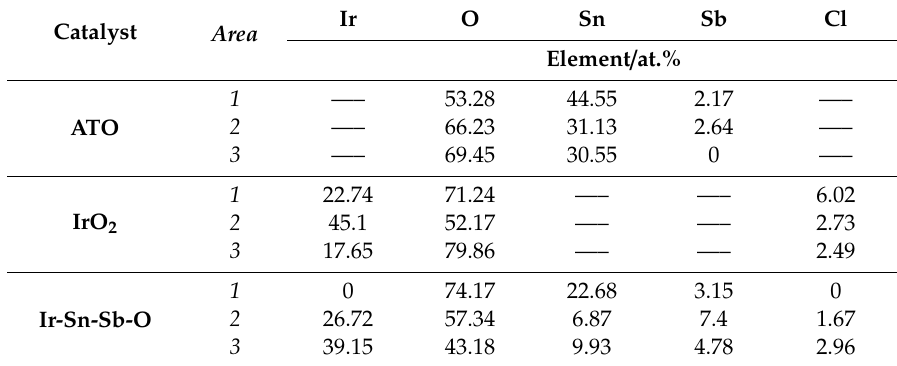
Table 2. EDS analysis for three selected areas for ATO, IrO 2 and Ir-Sn-Sb-O materials.